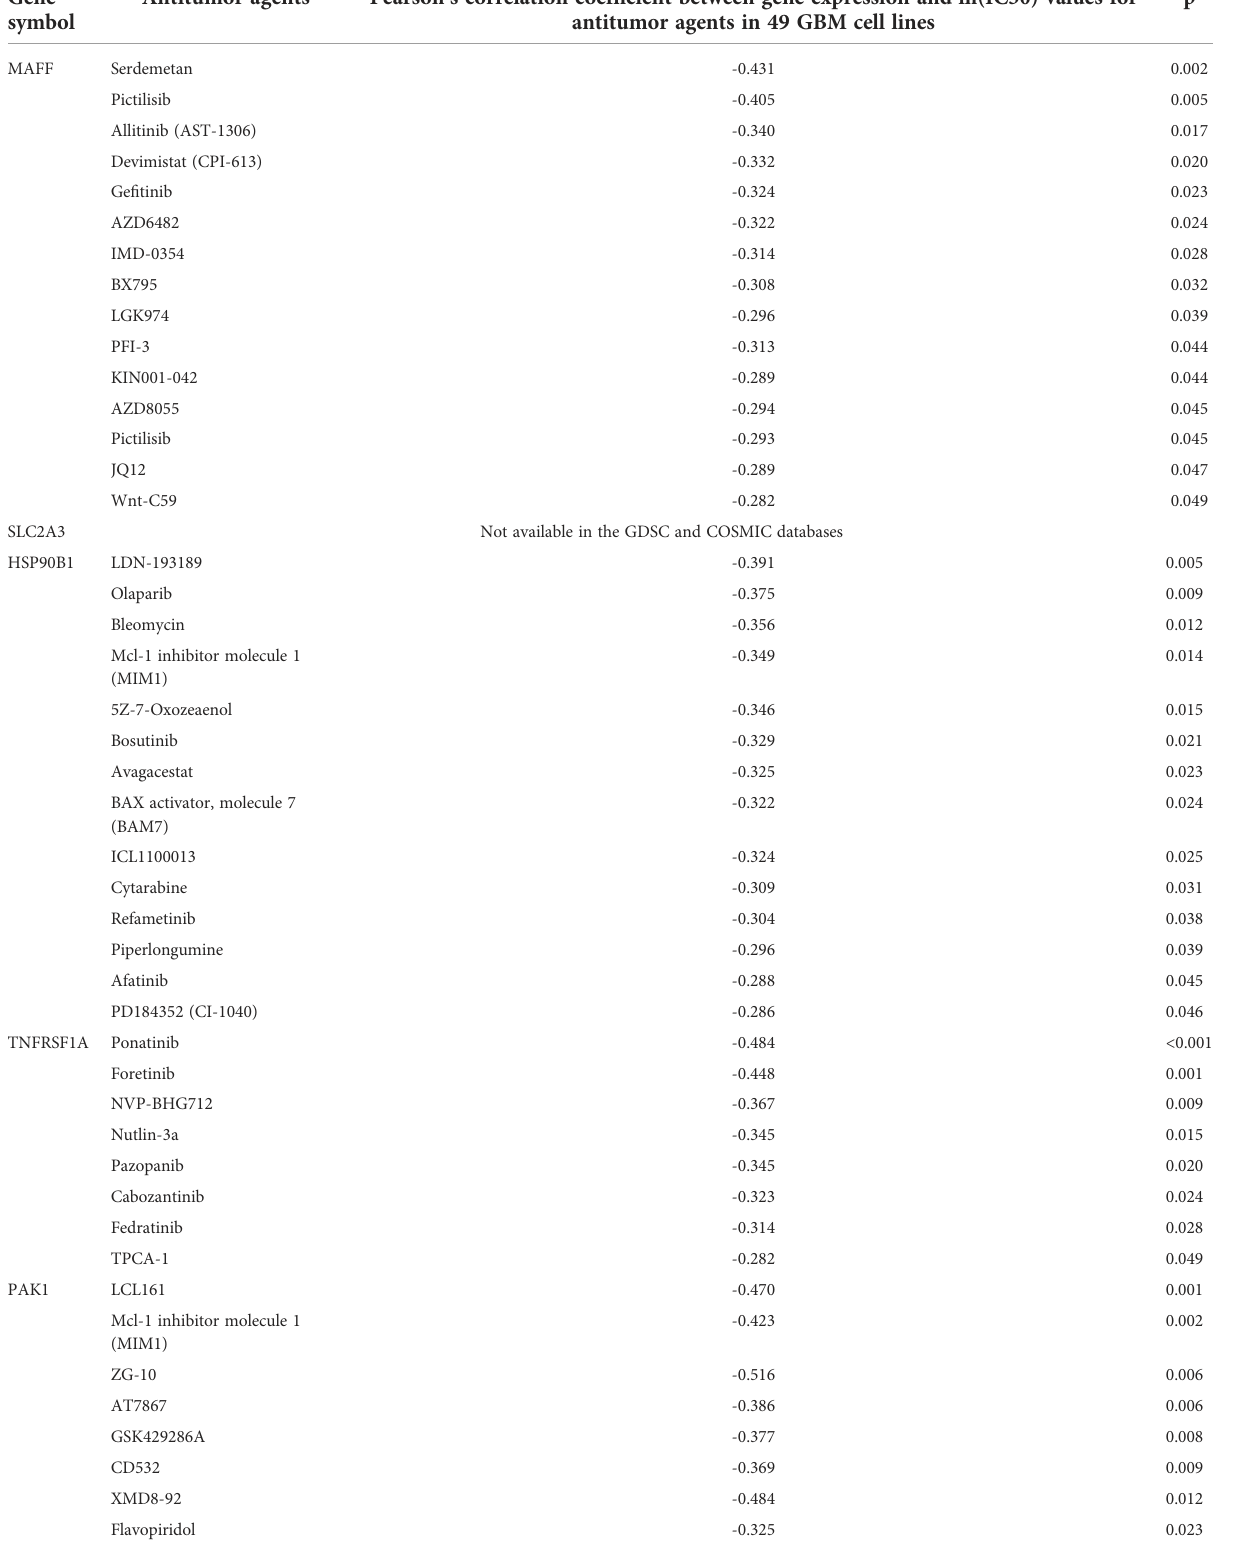
TABLE 4 Identi fi cation of antitumor agents for the genes signi fi cantly associated with poor prognosis in GBM. Gene